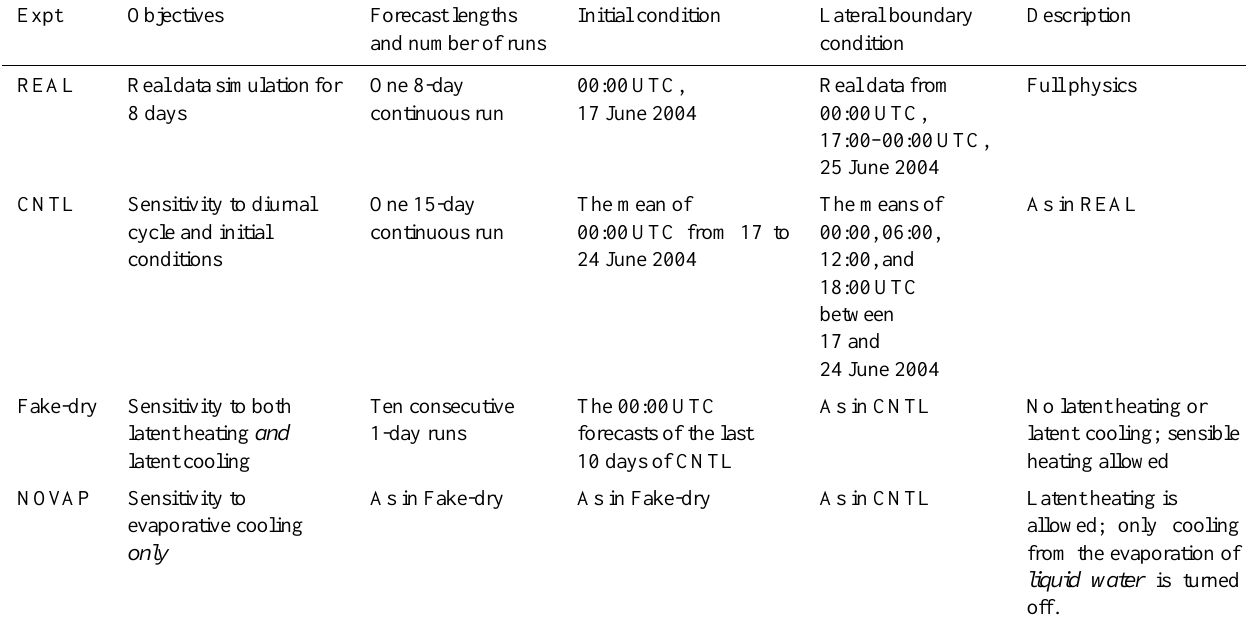
Table 1. Summary of WRF numerical